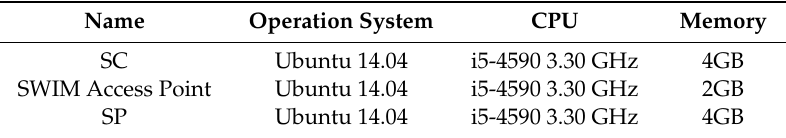
Table 2. The experimental PC hardware configuration.